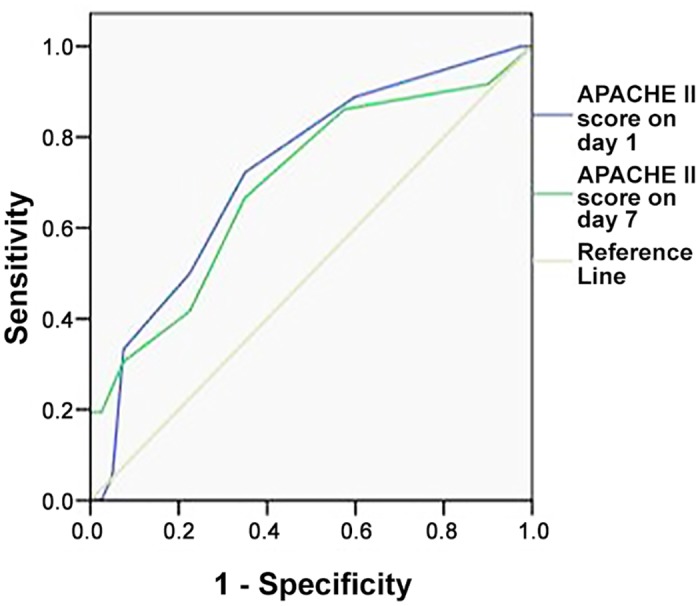
ROC curve of APACHE II score on day 1 versus APACHE II score on day 7 in predicting ACS.